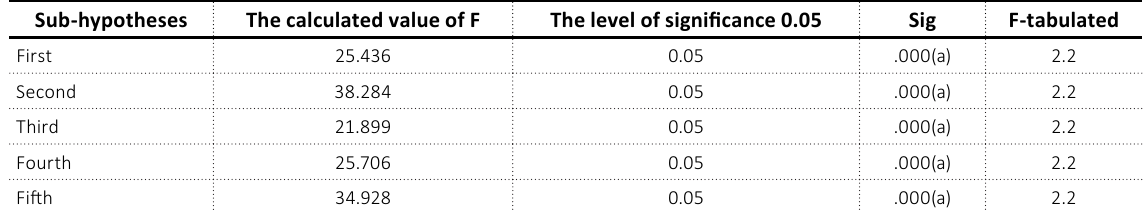
Table 9. Analysis of variance (ANOVA) for independent variables addressing the financial bankruptcy from an Islamic perspective